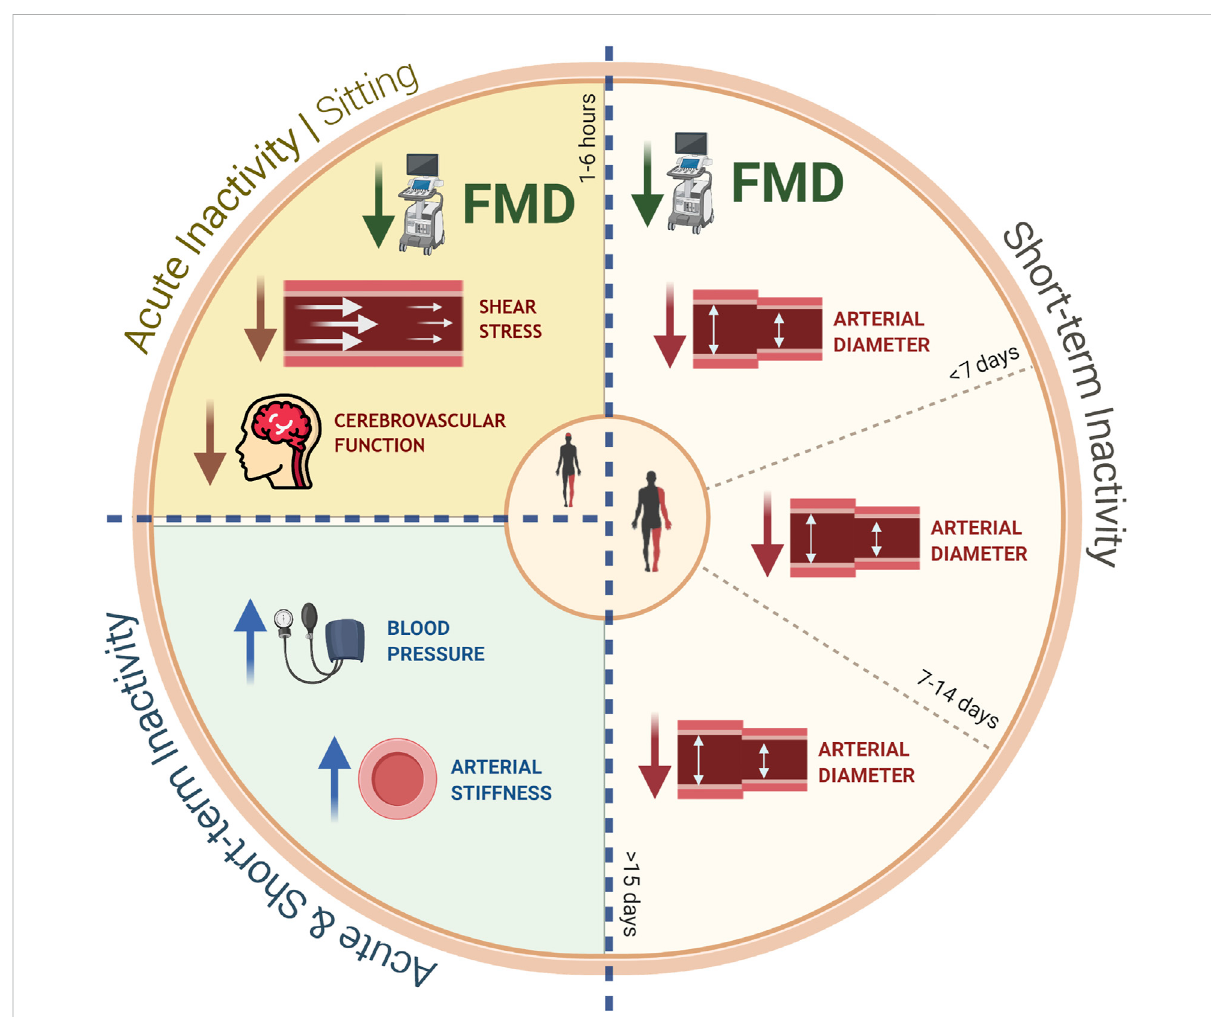
FIGURE 1 Summary of the negative effects of both acute (sitting) and short-term (e.g., step-reduction, limb immobilization, bed rest) inactivity protocols on peripheral vascular health in humans: sitting for up to 6 h results in a reduction in FMD, shear stress/rate, and cerebrovascular function;